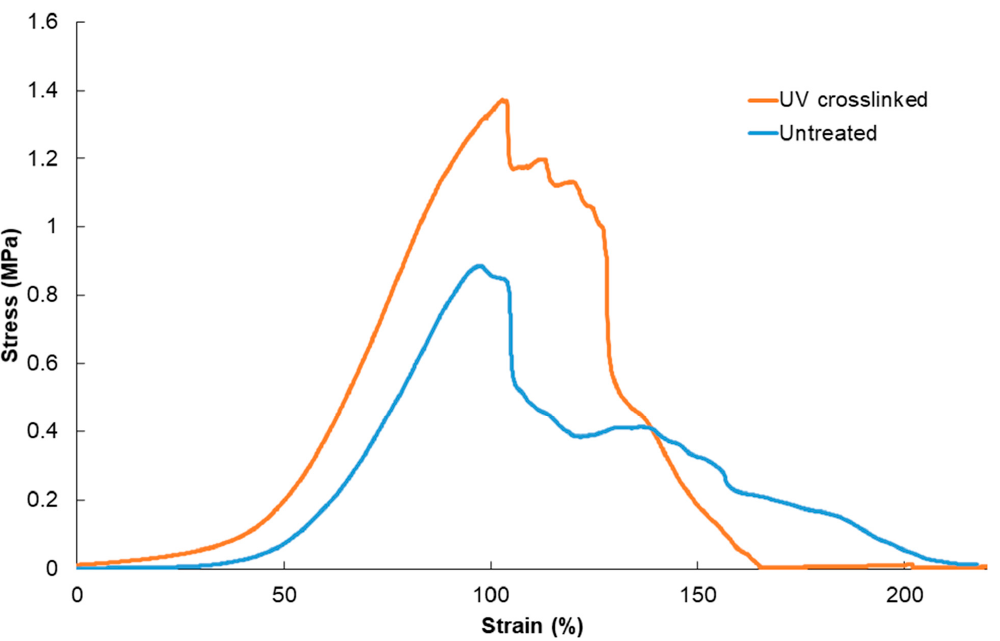
Figure 3. Representative stress versus strain plot of porcine adventitial specimens subjected to uniaxial tensile deformation in an Instron-type mechanical tester. The treated specimen was exposed to UV-A (365 nm) radiation for 10 min at an irradiance of 45 mW/cm 2 prior to testing.